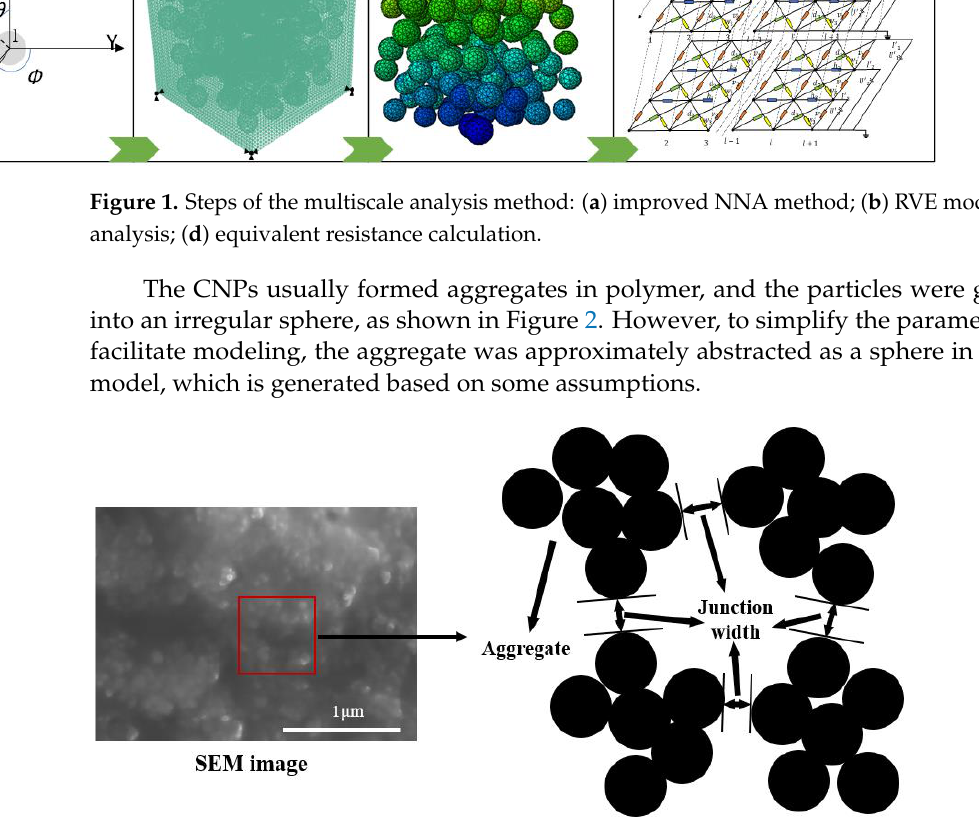
Figure 1. Steps of the multiscale analysis method: ( a ) improved NNA method; ( b ) RVE model; ( c ) FE analysis; ( d ) equivalent resistance calculation.